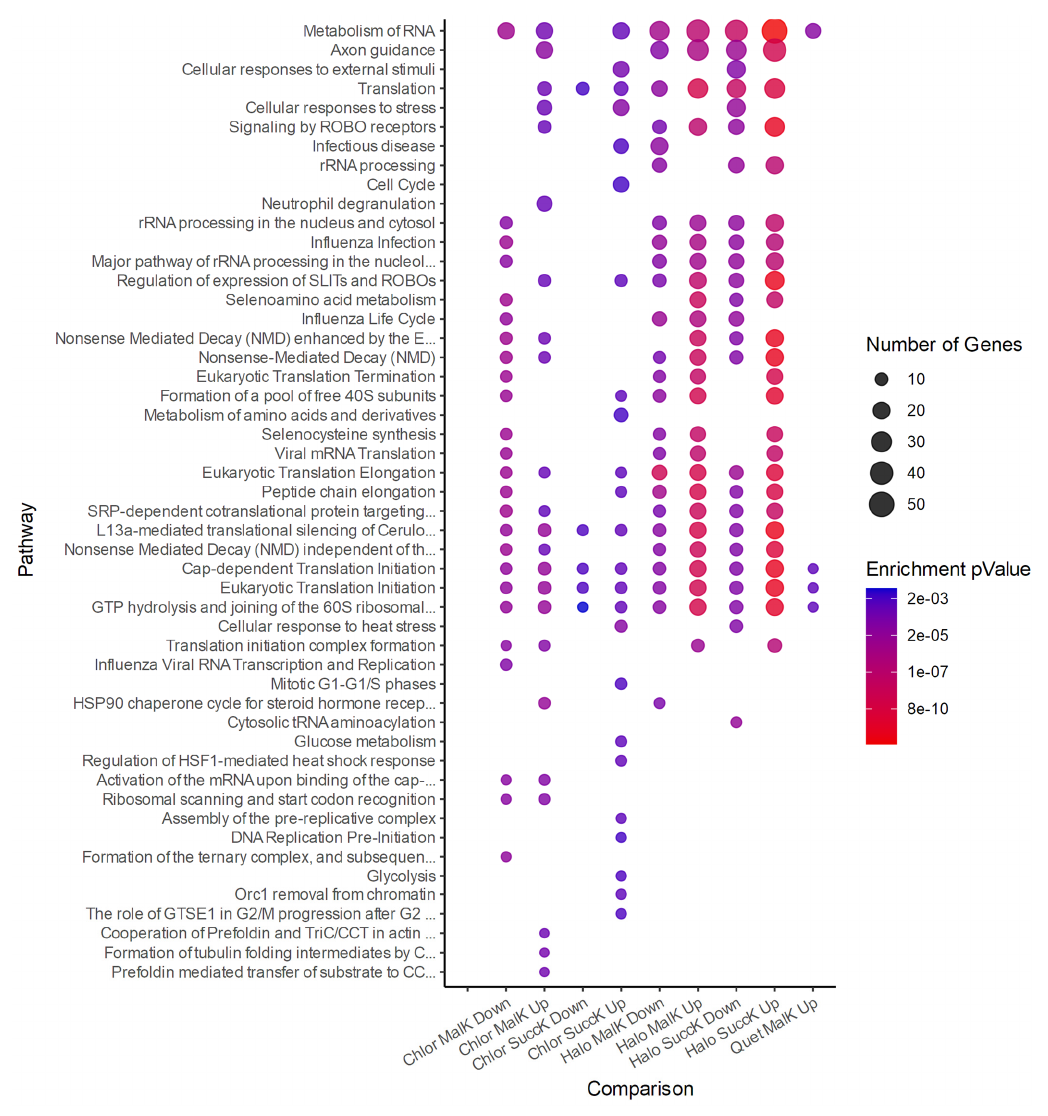
Figure 2. Visualization of biological pathways enriched by proteins found with higher (Up) or lower (Down) levels of succinylation (SuccK) or malonylation (MalK), induced by haloperidol (Halo), chlorpromazine (Chlor), and quetiapine (Quet) exposure in MO3.13 cells, determined by the Reactome.org database. The number of gene names for each enriched pathway determines the size of the dot, while the colors represent the FDR for the pathways. Comparisons not listed did not enrich for any pathways with FDR < 1% and pathways containing fewer than a total of 5 gene names were excluded.